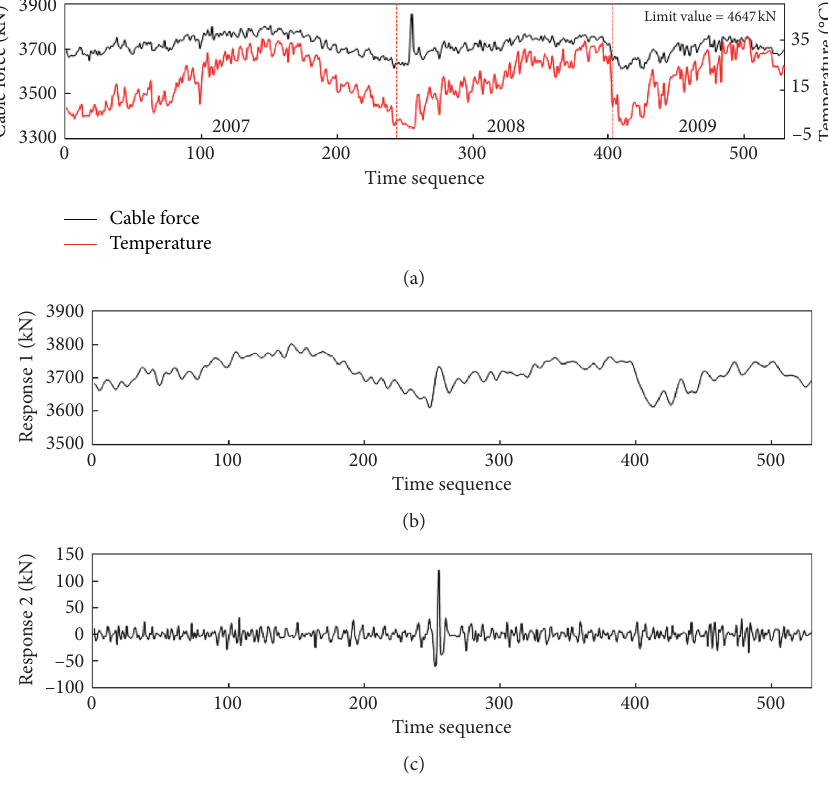
Figure 9: The subsignal of monitoring data after wavelet